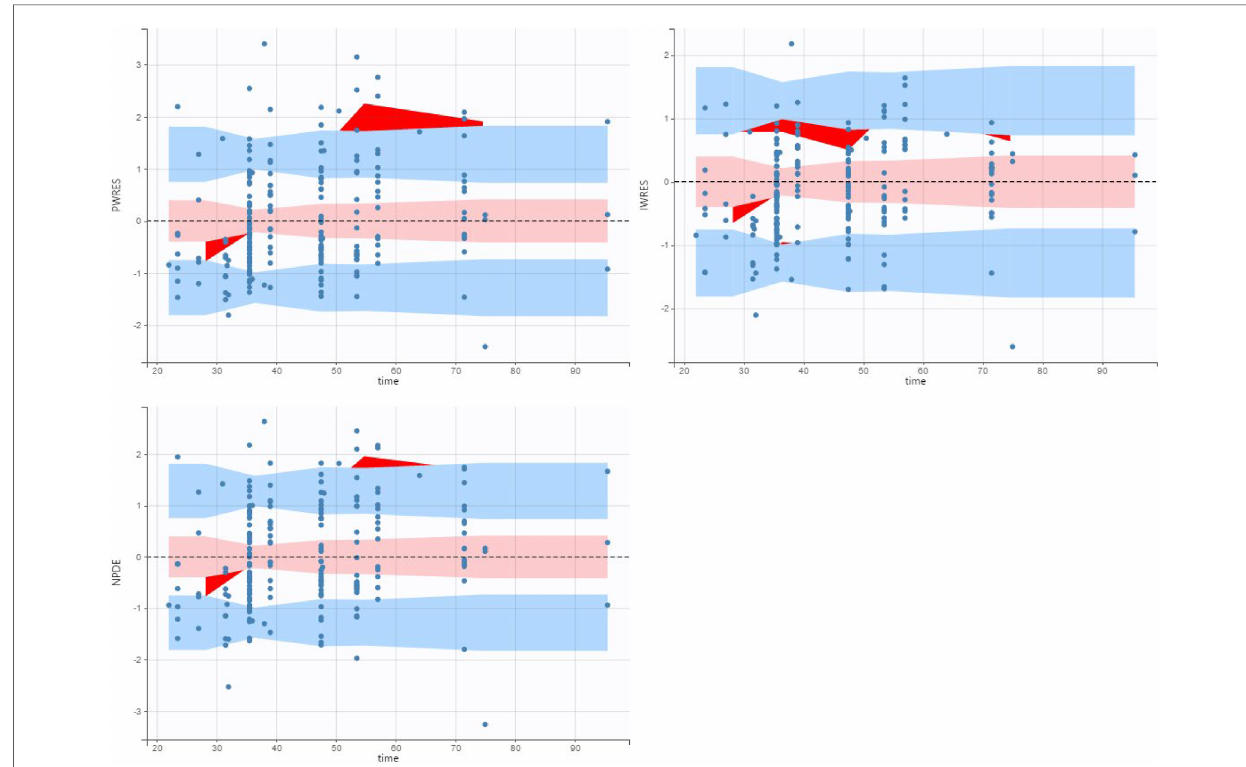
FIGURE 3 Population weighed residuals (top left), individual weighed residuals plot (top right) and normalized prediction distribution error plot (bottom left) for the fi nal population pharmacokinetic